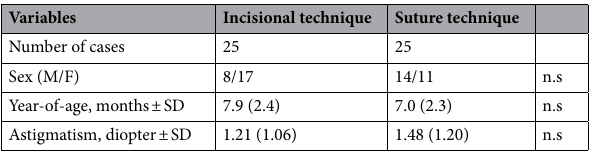
Table 1. Characteristics of patients enrolled in this study. n.s., not significant.